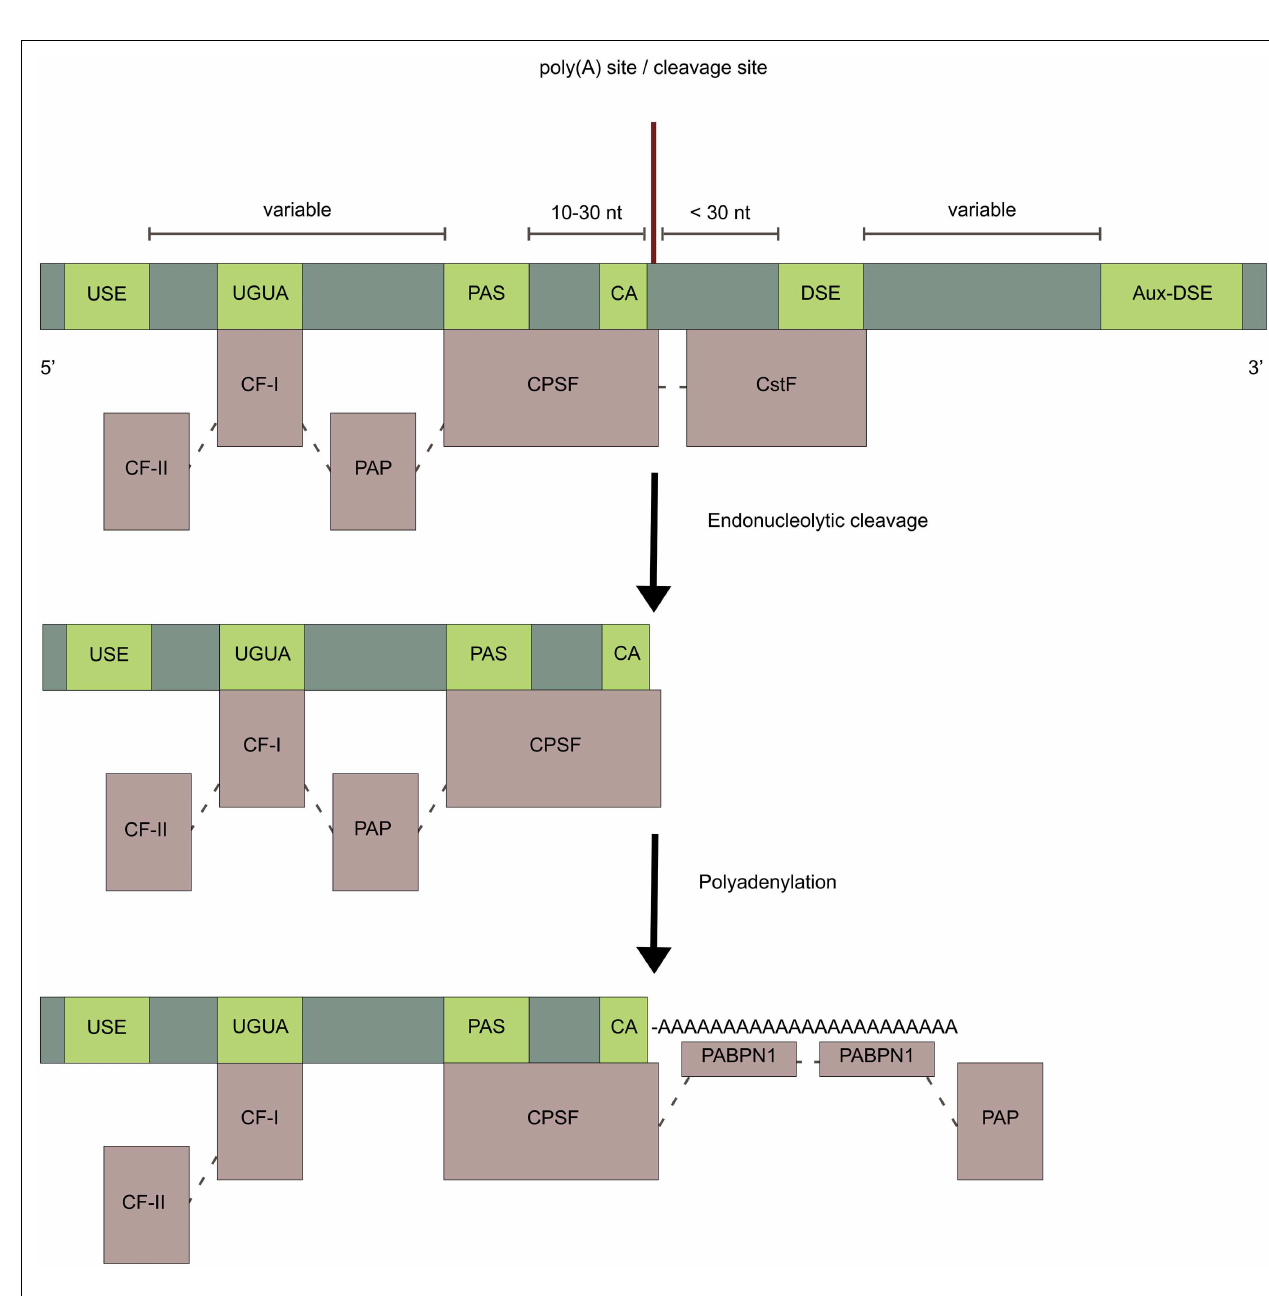
3 (cid:48) of a CA dinucleotide. After cleavage, an untemplated poly(A) tail of about 250 adenosine-nucleotides, is added to the upstream cleavage product by PAP.This is stimulated by the CPSF through the nuclear poly(A)-binding protein (PABPN1) which binds the growing poly(A) tail and controls its